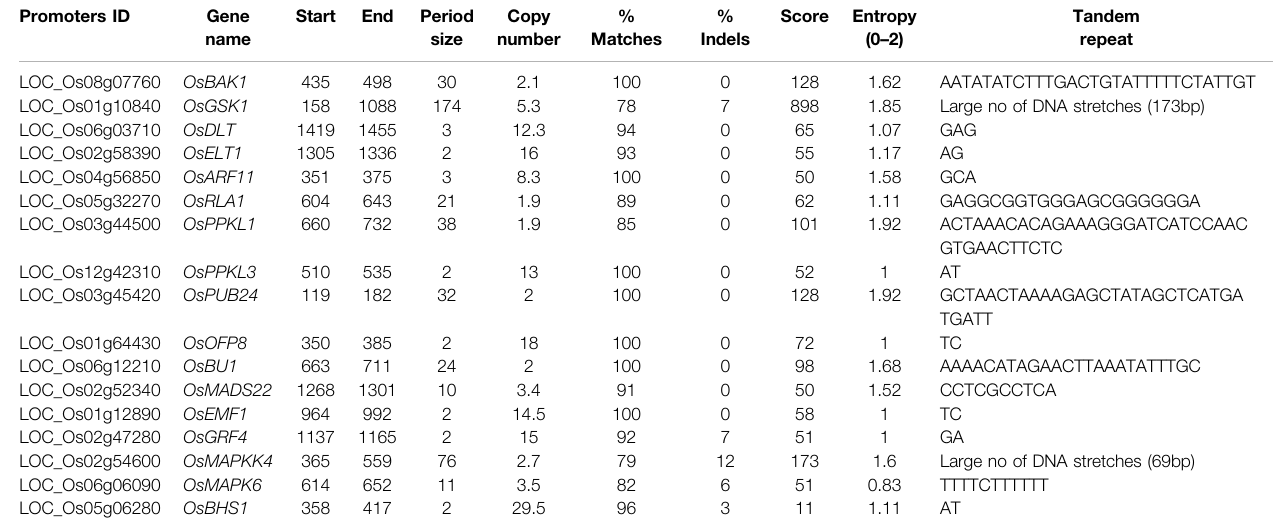
TABLE 3 | List of promoter regions of the BRs signaling-related genes containing tandem